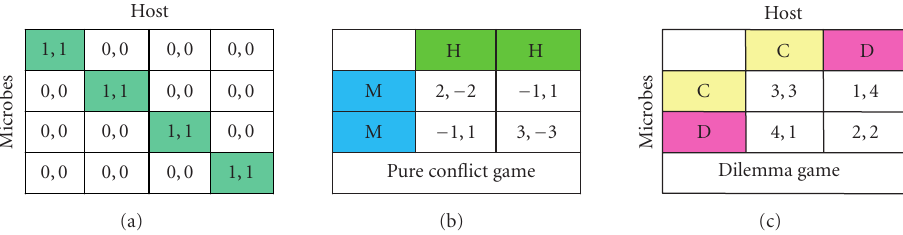
Figure 5: (a) Pure cooperative game. (b) Pure conflict game. H: host; M: microbes. (c) Dilemma game. The number in the left of each pair indicates the payo ff for microbes, and the right, the host. Higher numbers represent greater payo ff for the individual. Two strategies (Cooperation (C) and Defection (D)) are